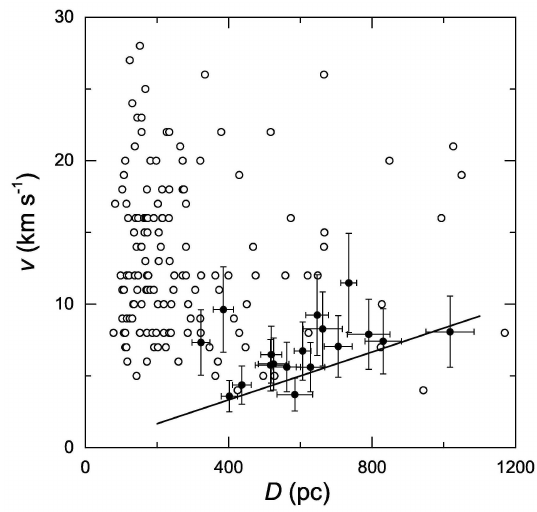
Fig. 4. The velocity of propagating star formation in the identified supershells (filled circles) and the expansion velocity of the H I holes (Deul & den Hartog 1990) (open circles) vs. the size of a given structure. The expansion velocities of the H I holes are accurate to 2 km s − 1 , and their age errors are ∼ 30 %. Solid line indicates the selection limit for the supershell age 60